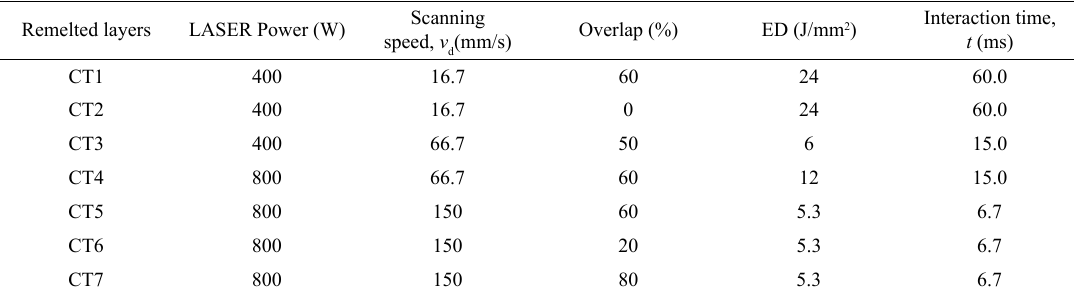
Table 1. LASER processing parameters, overlaps, calculated energy density (ED, equation 1) and interaction time (equation 2), for remelted layers (CT), used in the LASER surface treatment of Fe60Cr8Nb8B24 (at%) alloy. Remelted layers